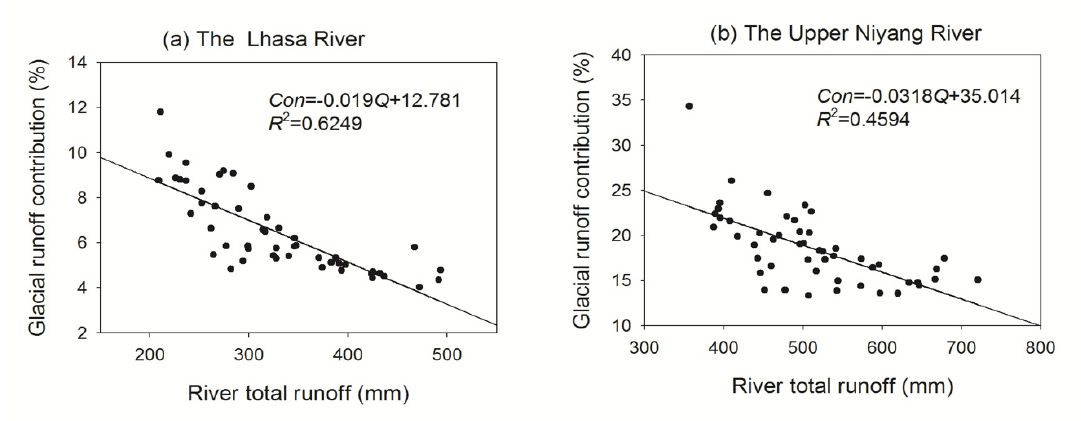
Figure 12. Scatterplots of glacier runoff contribution (Con) versus river total runoff (Q) over the LRB ( a ) and UNRB ( b ).